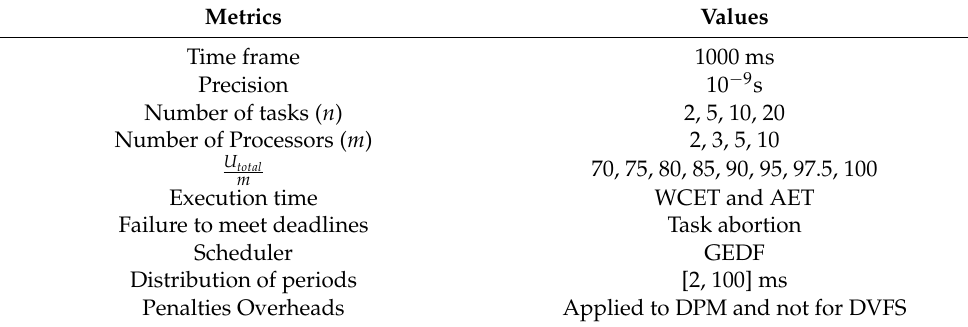
Table 4. Simulation Evaluation Metrics of